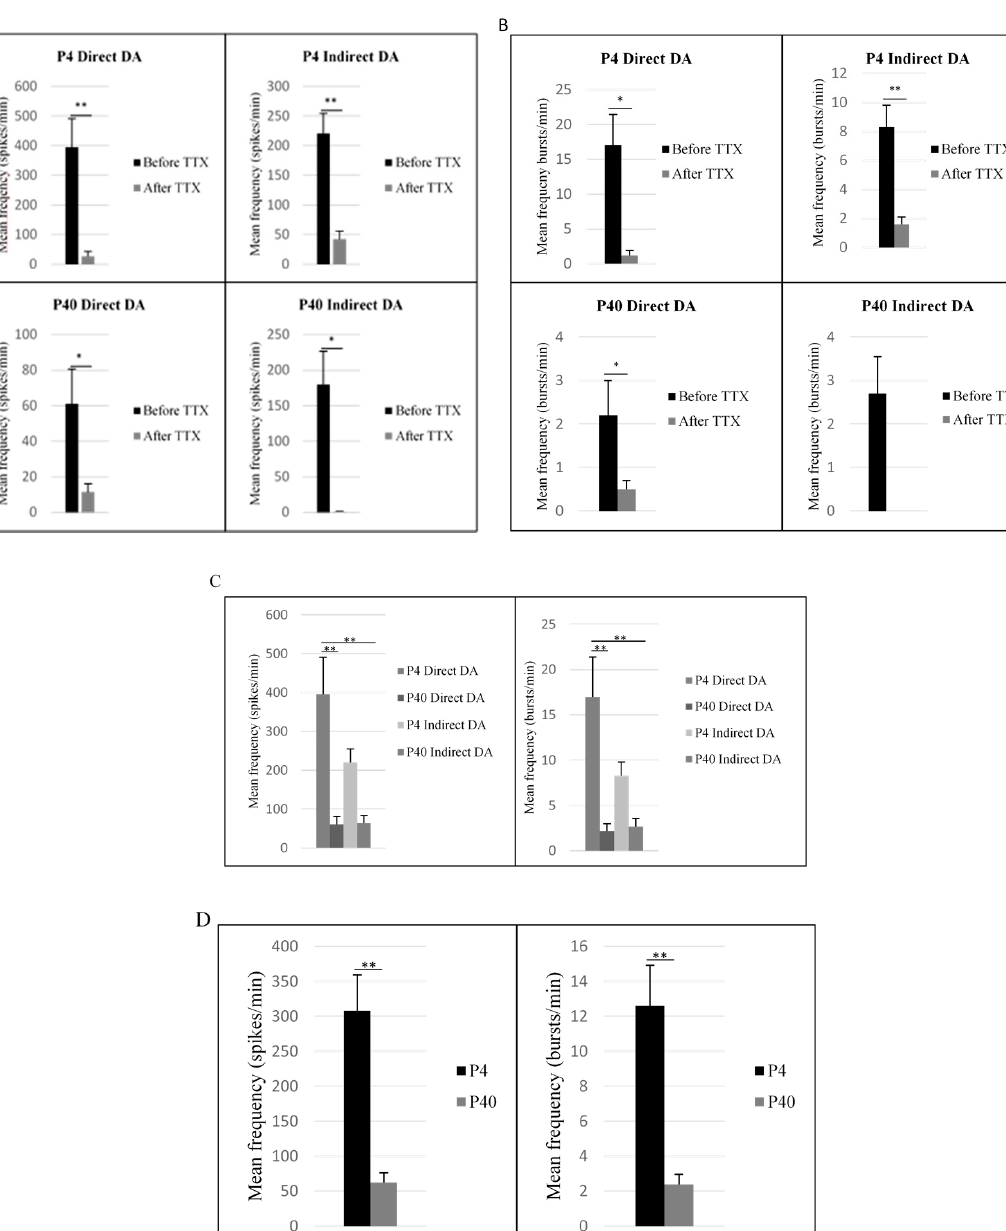
Figure 14. Spiking and bursting activity across all electrodes. ( A ) Spiking frequencies were significantly reduced in all four treatment groups following addition of TTX. ( B ) Bursting frequencies were significantly reduced in P4 MSCs following the direct and indirect inductions, and in P40 MSCs following the DDI. No bursting activity was detected following addition of 1 µ M TTX to the MEA well for P40 MSCs following the IDI. ( C ) P4 MSCs exhibited a significant increase in spiking and bursting frequencies following the DDI, as compared to P40 MSCs following both the DDI and IDI. ( D ) P4 MSCs exhibited an increase in spikes and bursts per minute as compared to P40 MSCs following either the DDI or IDI. Results are presented as mean frequencies (spikes or bursts per minute) ± SEM; * p <